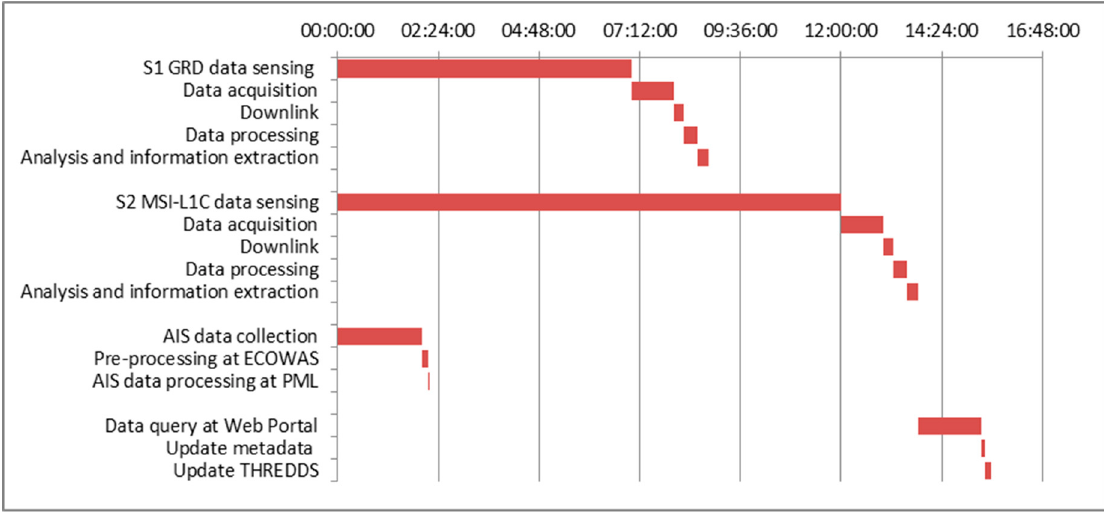
Figure 20. Timing diagram of data processing operations.